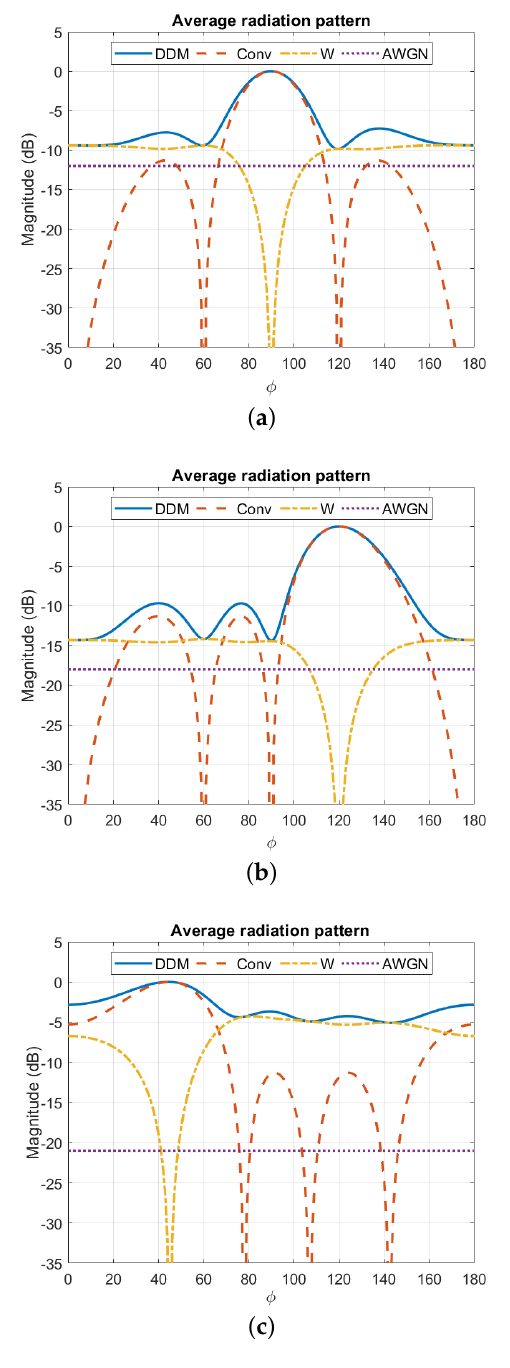
Figure 2. Array of four omnidirectional antennas along x-axis, spacing λ /2. Average radiation pat- terns in XY plane for dynamic directional modulation (DDM) ( P = 64). Zero mean artificial Gaussian noise. Only half-plane is plotted due to symmetry. ( a ) QPSK modulation, φ 0 = 90 ◦ , SNR( φ 0 ) = 12 dB, PE DDM = 75%. ( b ) 16-QAM modulation, φ 0 = 120 ◦ , SNR( φ 0 ) = 18 dB, PE DDM = 90%. ( c ) 8-PSK modulation, φ 0 = 45 ◦ , SNR( φ 0 ) = 21 dB, PE DDM =